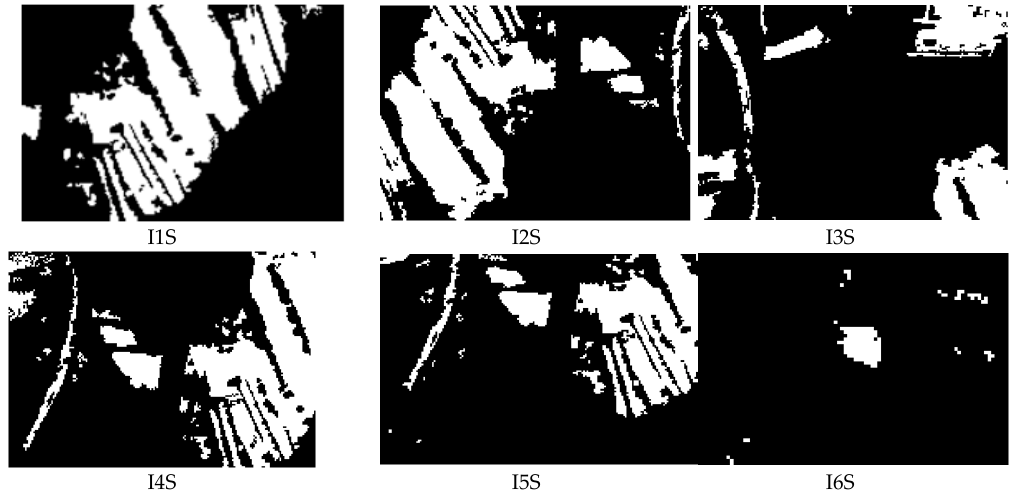
Figure 11. Images segmented for flood evaluation. White—flooded areas; black—non flooded areas.